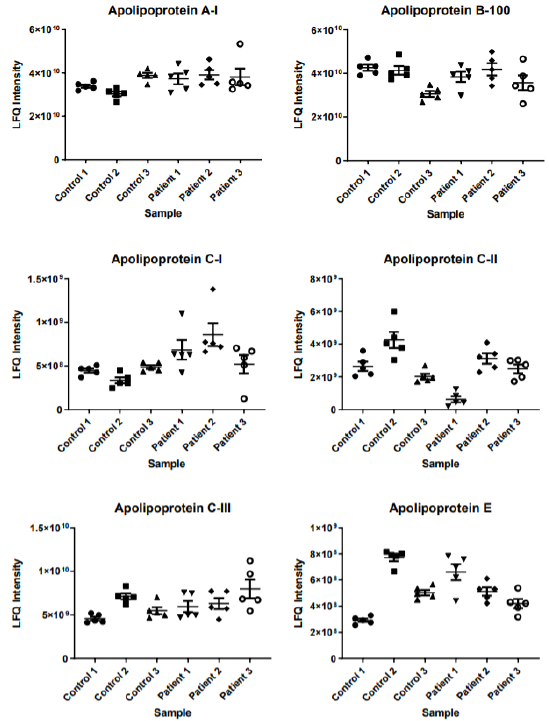
Figure 3. Clustering patterns for a selection of apolipoproteins. Reference values and uniprot-accession codes: apolipoprotein A-I (P02647) 1.2 – 1.8 g/L; apolipoprotein B-100 (P04114) 0.8 – 1.4 g/L;